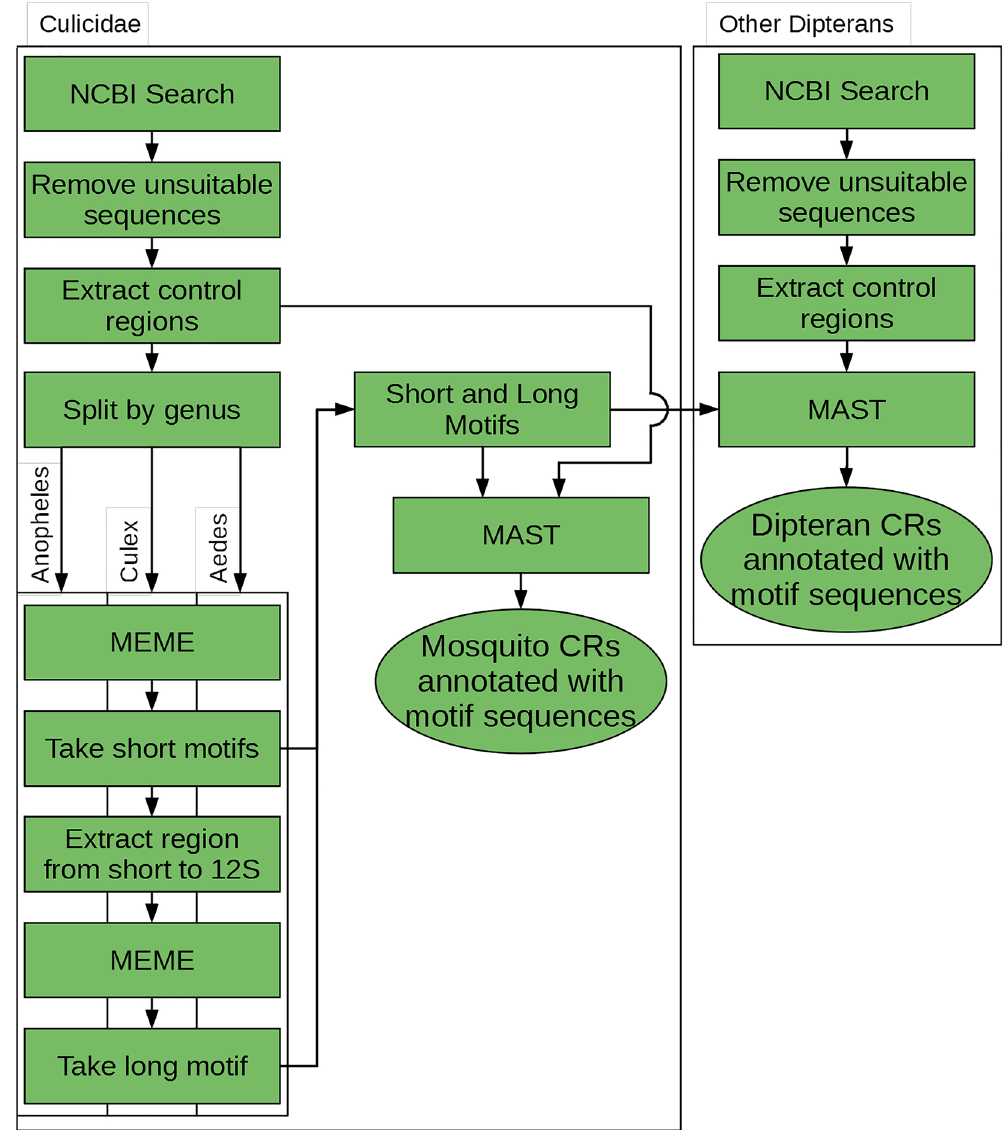
Figure 1. Overview flowchart showing the data processing. Anopheles , Culex , and Aedes sequences were treated separately, but used the same